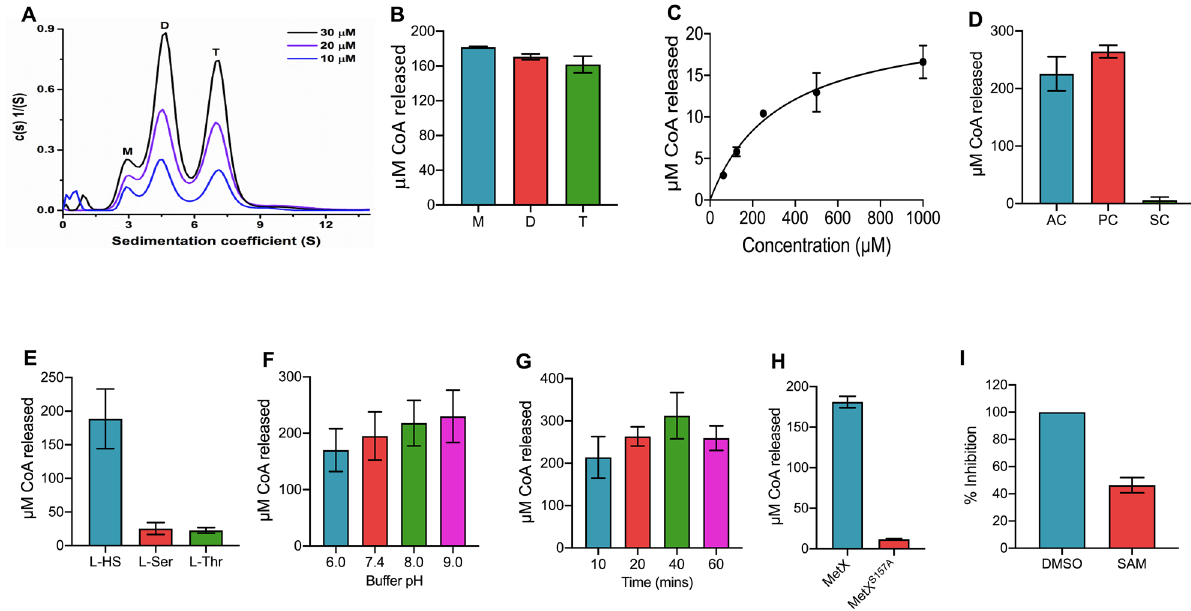
Figure 2. Biochemical characterization of Rv3341. ( A ) Oligomeric state of Rv3341 enzyme. Analytical ultracentrifugation was performed using purified (His) 6 -MetX at 10 µM, 20 µM and 30 µM concentration in 20 mM Tris–Cl buffer, pH-7.5 containing 150 mM NaCl. ( B ) Enzymatic activity of different oligomeric forms of Rv3341. The amount of CoA released in enzymatic reactions in the presence of 0.5 µM of monomer, dimer or tetramer form of Rv3341 was determined. ( C ) Michaelis Menten plot for Rv3341 enzymatic activity. The enzymatic reactions were performed in vitro using 1 mM L-homoserine and different concentrations of acetyl- CoA. ( D , E ) Substrate specificity of Rv3341 enzyme. In order to determine the substrate specificity of Rv3341 for acetyl-CoA (D), enzymatic reactions were performed in the presence of either 1.0 mM acetyl-CoA (AC) or propionyl-CoA (PC) or succinyl-CoA (SC). The specificity for L-homoserine was determined by performing enzymatic reaction in the presence of either 1.0 mM L-homoserine (L-HS) or L-serine (L-Ser) or L-threonine (L-Thr). ( F ) Effect of buffer pH on Rv3341 activity in vitro. HSAT activity assays were performed in buffers of pH in the range of 6.0–9.0. ( G ) Time kinetics analysis of Rv3341 activity. The HSAT activity was calculated after 10 min, 20 min, 40 min and 60 min post-incubation with substrates. ( H ) HSAT activity of wild type and mutant proteins. The enzymatic assays were performed using 0.5 µM of purified wild type and mutant protein in assay conditions containing 1.0 mM L-homoserine and 1.0 mM acetyl-CoA. ( I ) Inhibition of Rv3341 activity by SAM. Rv3341 enzymatic activity was calculated in presence of 100 µM of SAM. The amount of coenzyme A